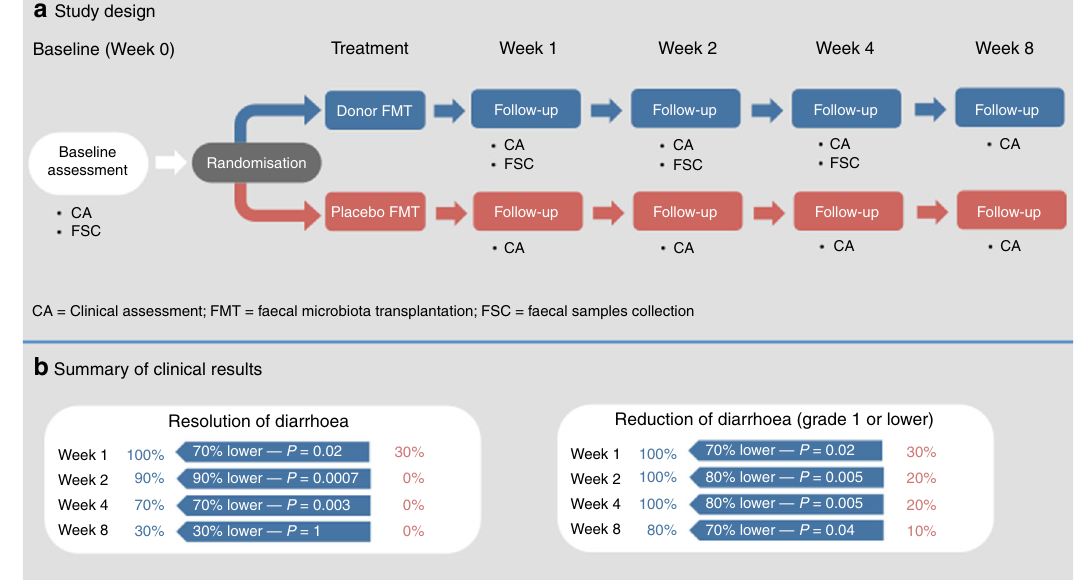
Fig. 1 Study design and summary of clinical results. a Study design: after baseline clinical and microbiome assessments, patients were randomised to receive either donor faecal microbiota transplantation (D-FMT) or placebo FMT (P-FMT). Then, all patients were followed up to 8 weeks (follow-up visits at 1, 2, 4 and 8 weeks after treatments). b Summary of clinical results: D-FMT was signi fi cantly more effective than P-FMT in achieving the complete resolution of TKI-induced diarrhoea at 1 week ( n = 10 vs n = 3, 100% vs 30%, p = 0.02), 2 weeks ( n = 9 vs n = 0, 90% vs 0%, p = 0.0007), 4 weeks (primary outcome, n = 7 vs n = 0, 70% vs 0%, p = 0.003), but not at 8 weeks of follow-up ( n = 3 vs n = 0, 30% vs 0%, p = 1), consistently with the single FMT infusion approach of the study. Nonetheless, the bene fi t of D-FMT over P-FMT in decreasing diarrhoea up to G1 grade or lower remained signi fi cant for the whole follow-up period, including 1 week ( n = 10 vs n = 3, 100% vs 30%, p = 0.02), 2 weeks ( n = 10 vs n = 2, 100% vs 20%, p = 0.005), 4 weeks ( n = 10 vs n = 2, 100% vs 20%, p = 0.005) and 8 weeks ( n = 8 vs n = 1, 80% vs 10%, p = 0.04) after the end of treatments. Differences in cure percentages were determined with Fisher ’ s exact test (with two-tailed p values). The Bonferroni adjustment was applied for multiple secondary